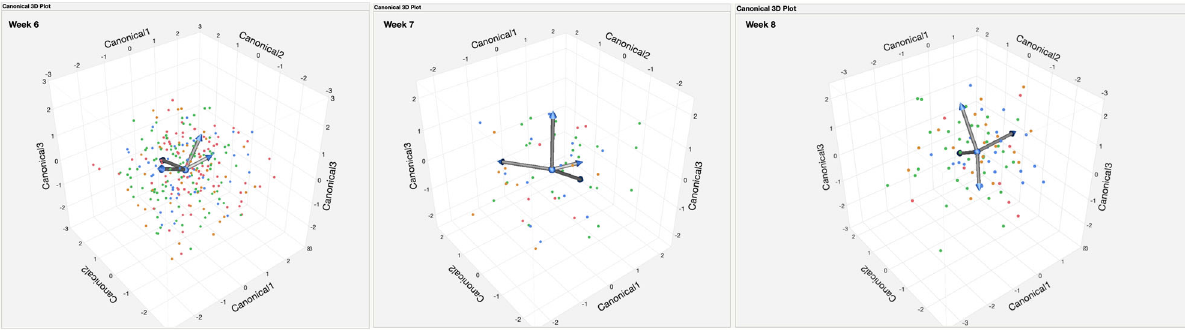
Fig. 4 3D canonical Plot for the linear discriminant analysis. The points have been colored by clusters. These de fi ne the three dimensions that provide maximum separation among the groups. Each canonical variable is a linear combination of the